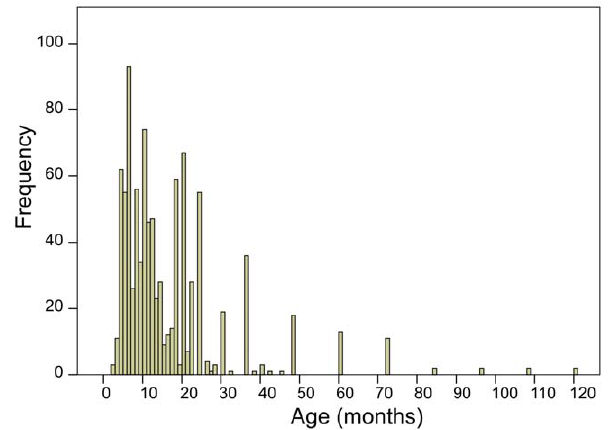
Figure 3. Frequency distribution of estimated age in months for 932 wild boar.